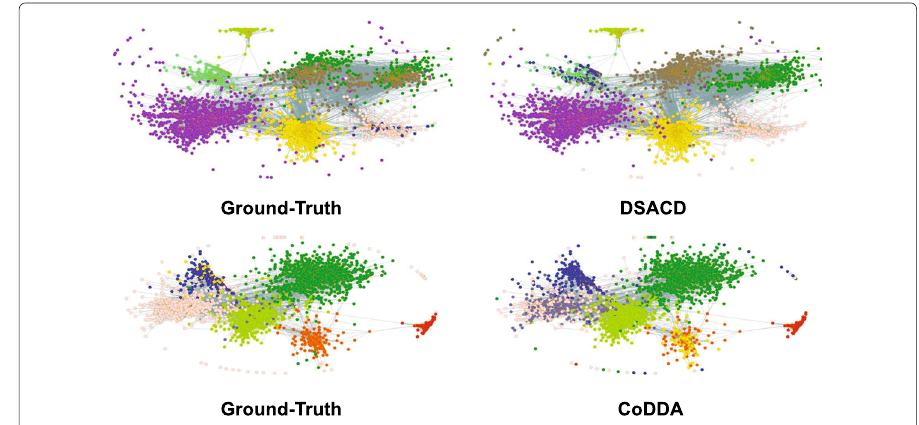
Fig. 12 Comparison of the CoDDA and the DSACD about the LiveJournal